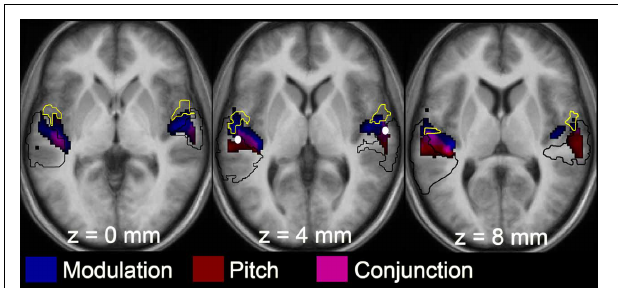
FIGURE 4 | Statistical T map from the 2 × 2 factorial ANOVA showing locations of the group-averaged responses for the main effects of slow modulation (blue) and pitch (red), and a conjunction for the two features (pink). The yellow border denotes Te 1.2 (lateral portion of HG) and the black border outlines PT (informed by Westbury et al., 1999). Activation is overlaid onto an average anatomical image made from the 12 individual listeners. The left hemisphere is on the left-hand side of each anatomical image. These images used an uncorrected threshold p < 0 . 05. This figure demonstrates the patterns of activation across the entire cortex, although the analyses were restricted to a 10-mm sphere centered on the white spots in the middle panel.